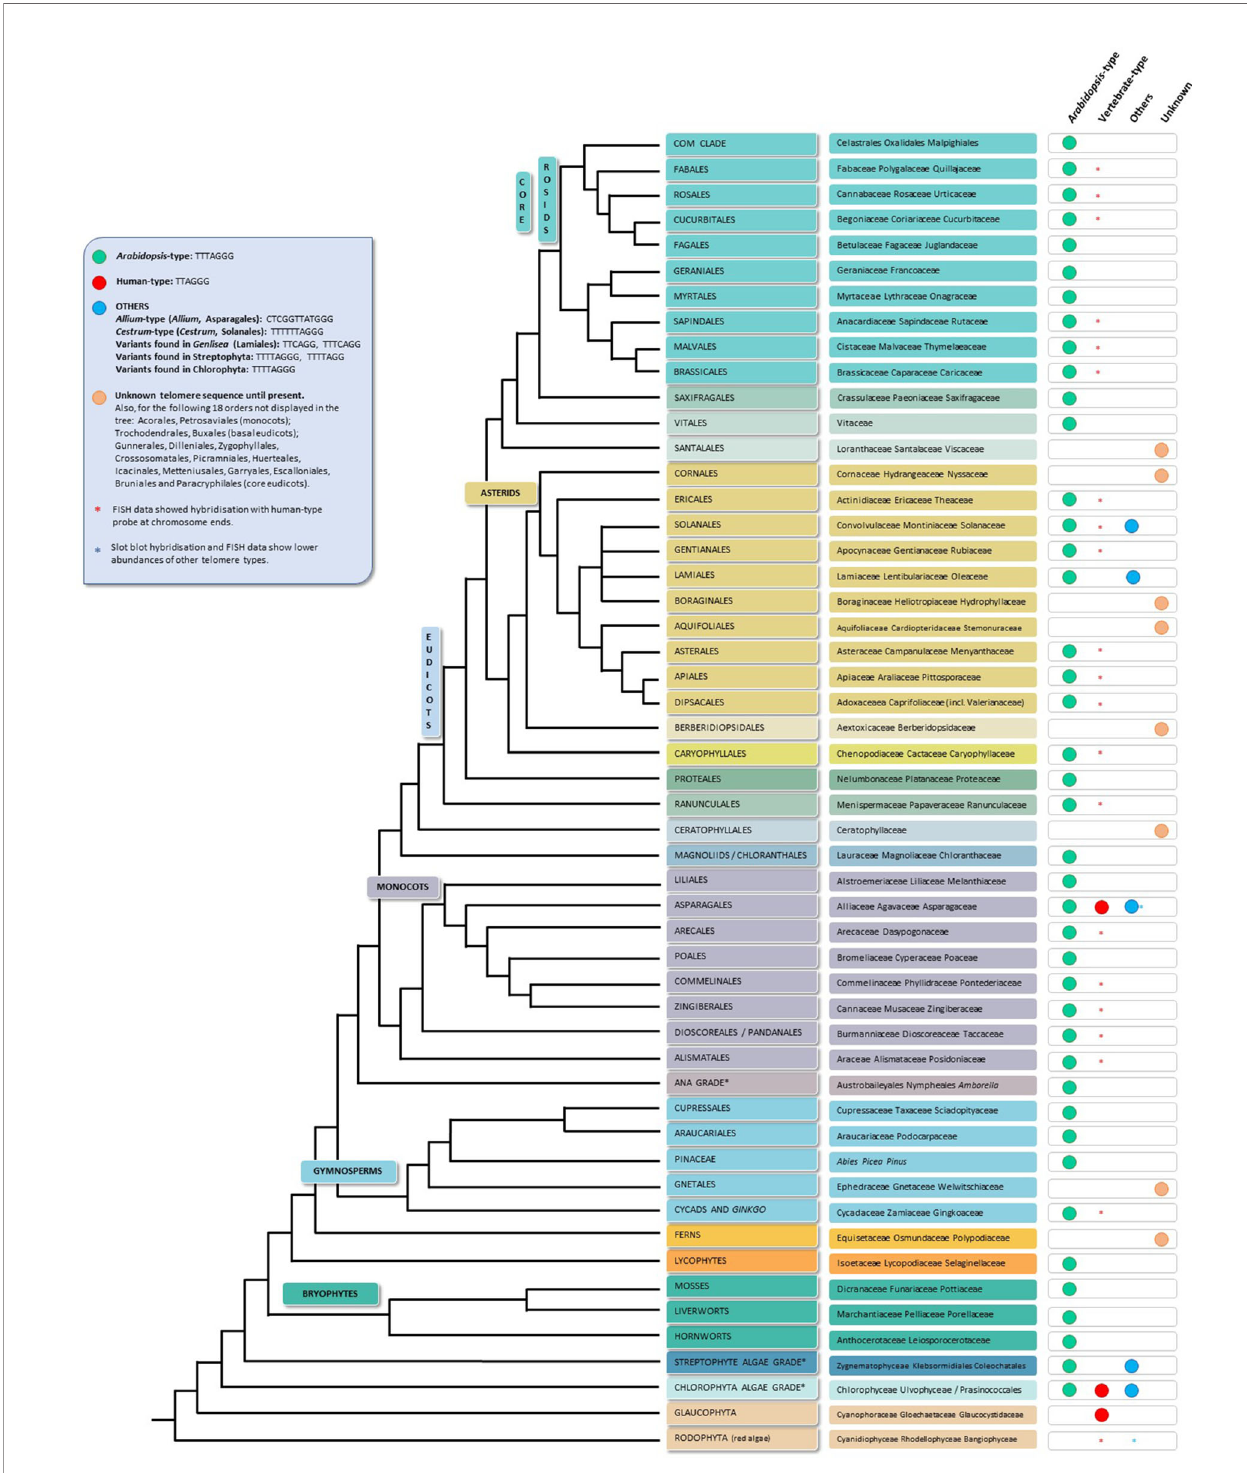
FIGURE 2 | Telomere motifs in Archaeplastida (plants in the broad sense), based on the APG IV (The Angiosperm Phylogeny Group 2016) and on the One Thousand Plant Transcriptomes Initiative (2019). Branch lengths do not express real time scales. For simplicity and to save space, certain polyphyletic “ groups ” (grades) marked with an asterisk in the tree have been represented by a single branch; for the same reason, several minor orders (listed in the blue square at the left upper side of the fi gure) are not depicted on the tree. The fi rst tip label usually refers to plant orders and in a few cases, to divisions, grades and even families; the second label displays representative families and in a few cases, representative orders or